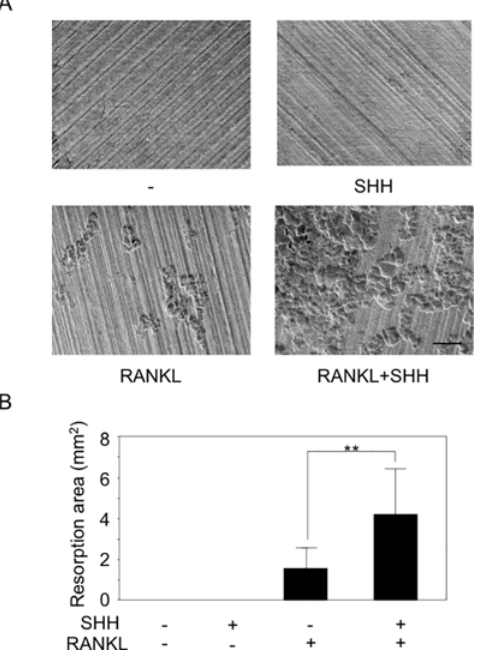
Fig 3. SHH stimulated bone resorptive activity of mature osteoclasts. ( A ) Bone resorptive activity of mature osteoclasts differentiated from CD11b + bone marrow cells were evaluated in a dentin slice. The data from a typical experiment are presented. Similar results were obtained in three separate experiments. ( B ) The resorbed areas on the slides were observed under a microscope and measured. The data from a typical experiment are presented. Data are shown as the mean ± SD. Statistically significant differences ( ** P < 0.01) between the indicated groups are marked by asterisks. Scale bar, 100